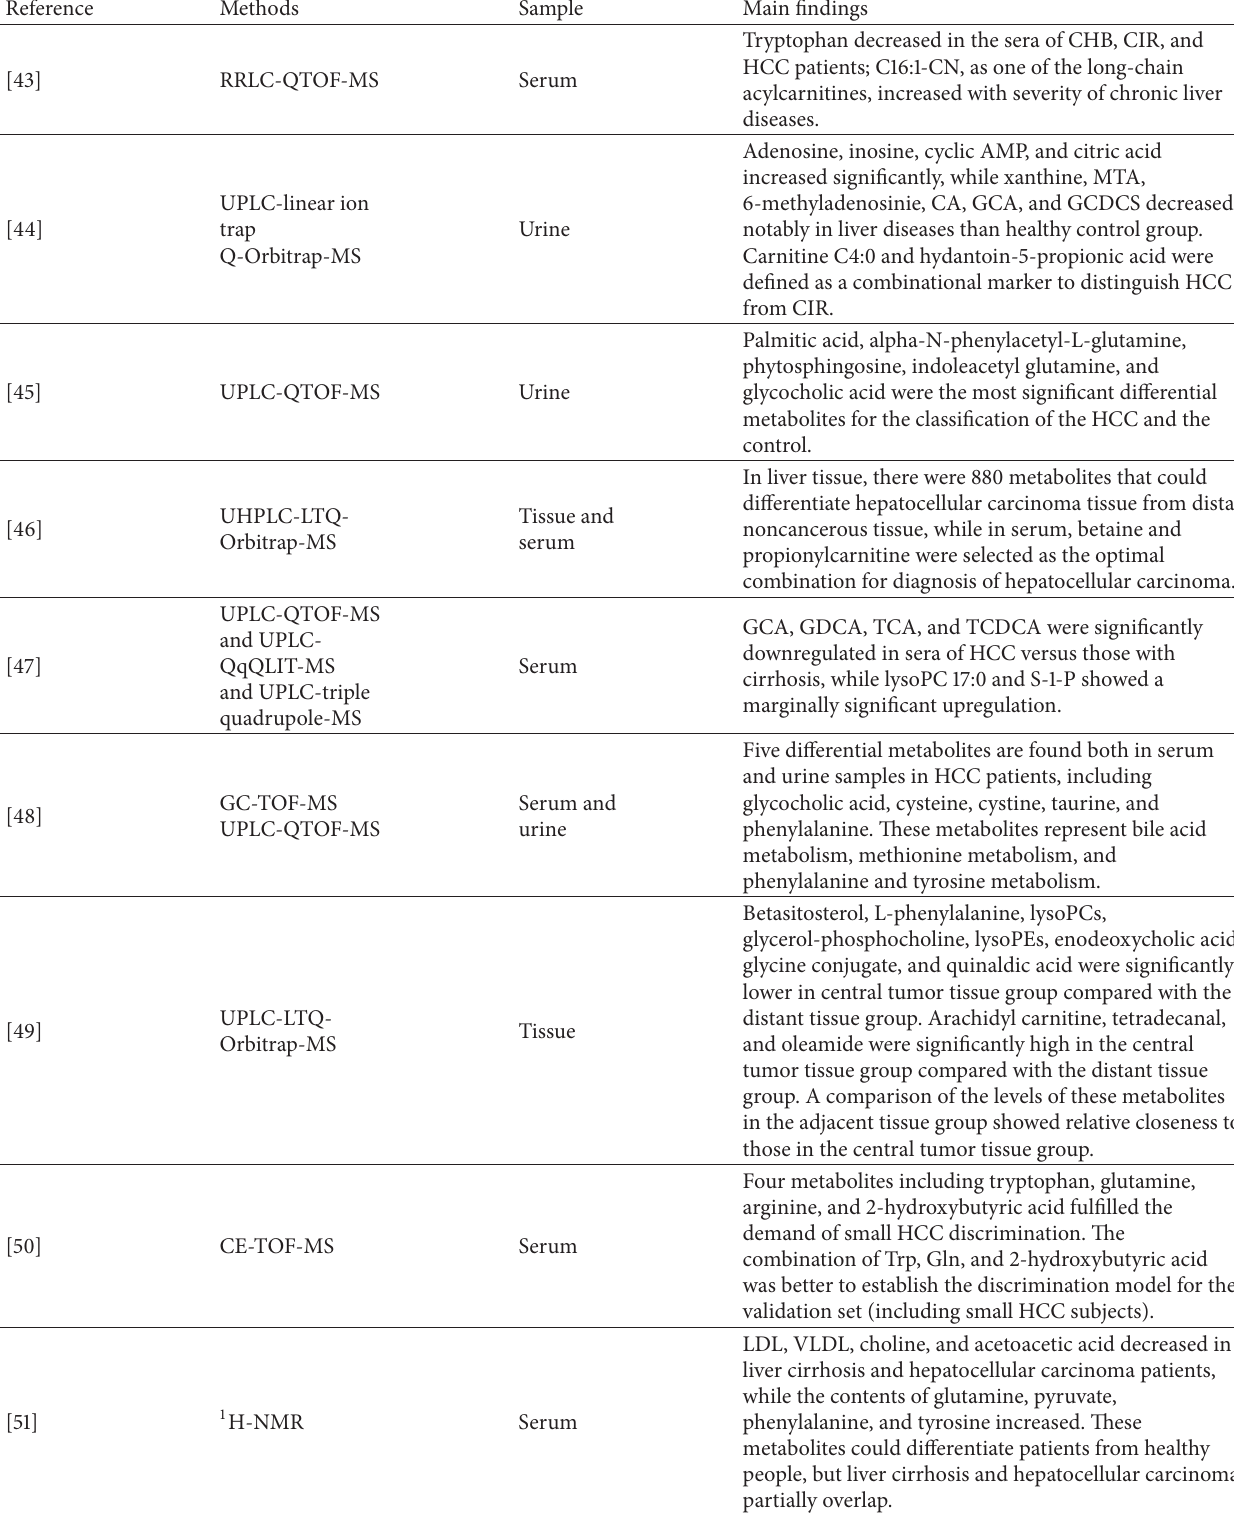
Table 7: The main results of relevant metabolomic studies on